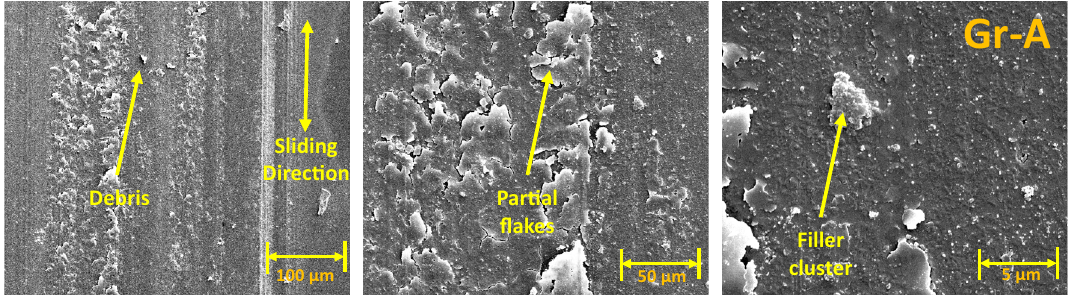
Figure 4. SEM images of Group A wear